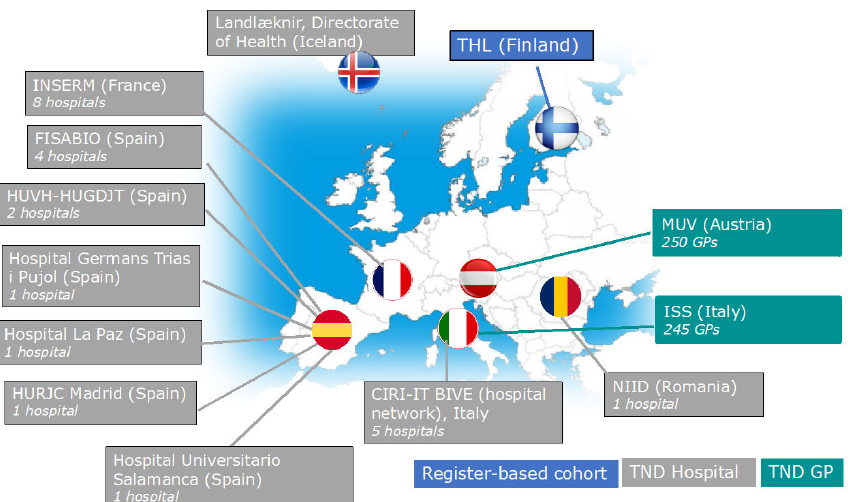
Figure 3. DRIVE study sites for the 2020/2021 season: 13 study sites from 7 different European